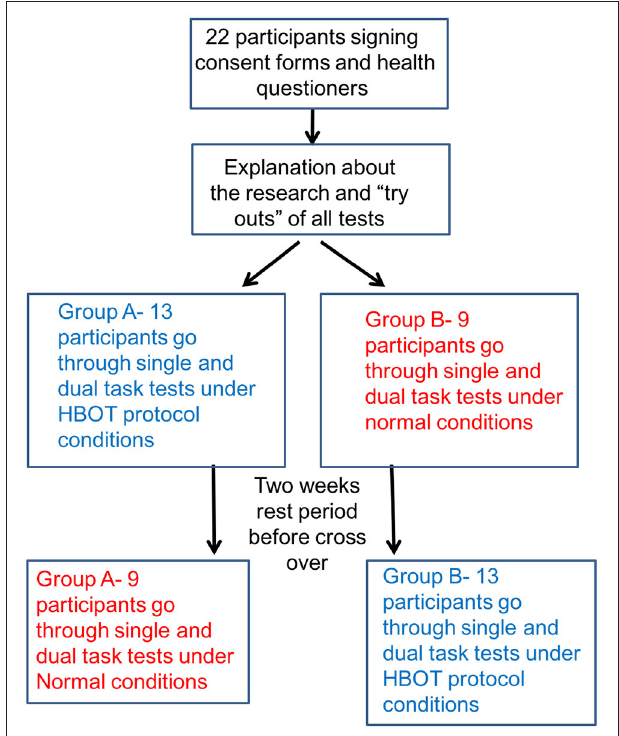
FIGURE 1 | Study protocol